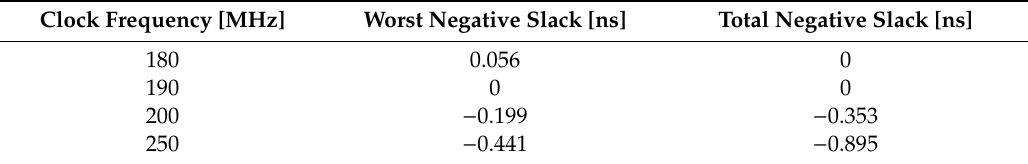
Table 3. Post-implementation simulation results carried out on the encryption system with di ff erent clock frequencies to establish the maximum operating frequency with a positive Worst Negative Slack (WNS)